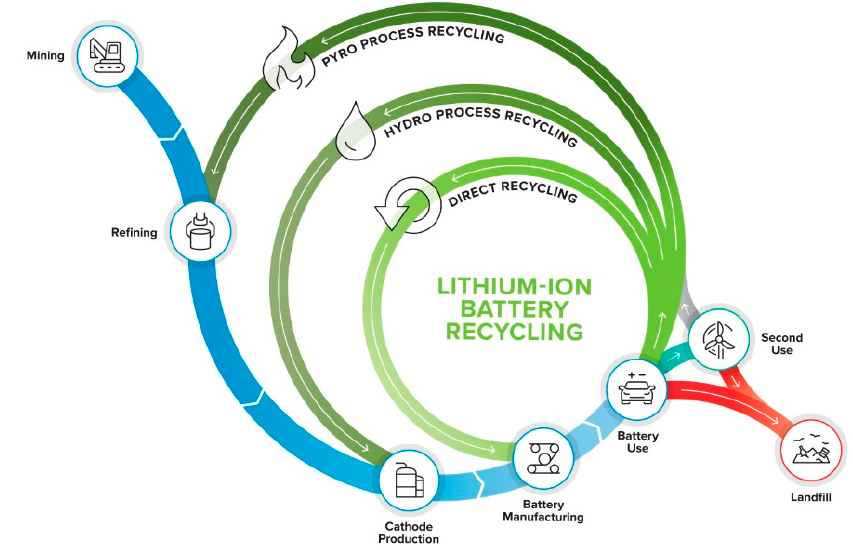
Figure 5. Lithium-ion battery lifecycle.